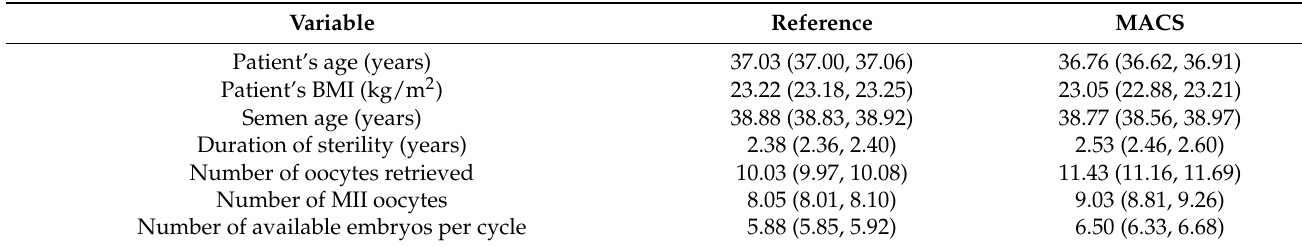
Table 1. Summary statistics for the main descriptive variables between the reference (semen samples processed according to routine clinical practice) and magnetic-activated cell sorting (MACS) groups in cycles using the patients’ autologous oocytes. The data show the mean and the 95% CI, as well as the p -value obtained using a t -test for the quantitative variables. For the categorical variables (*), results are expressed in proportions with their corresponding 95% CI and the p -value was computed using the chi-squared